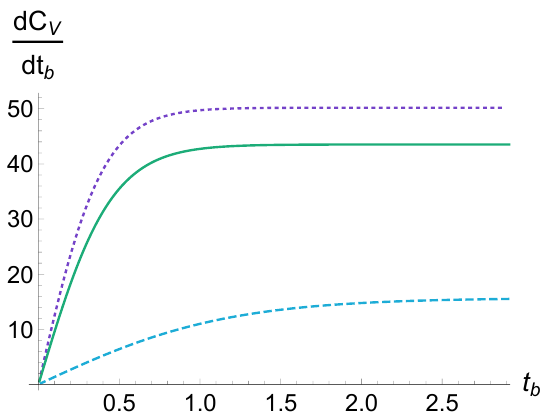
Figure 8 . dC V with M = 2 , ‘ = G N = 1 for J = 0 . 1 (purple dotted), J = 1 (green solid) and dt b J = 1 . 9 (blue